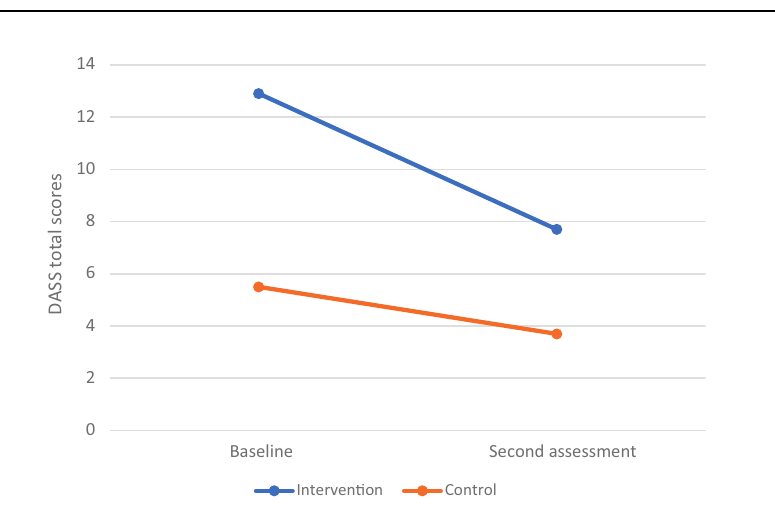
Table 2. Total DASS scores and subdomains for the online support group and the control group